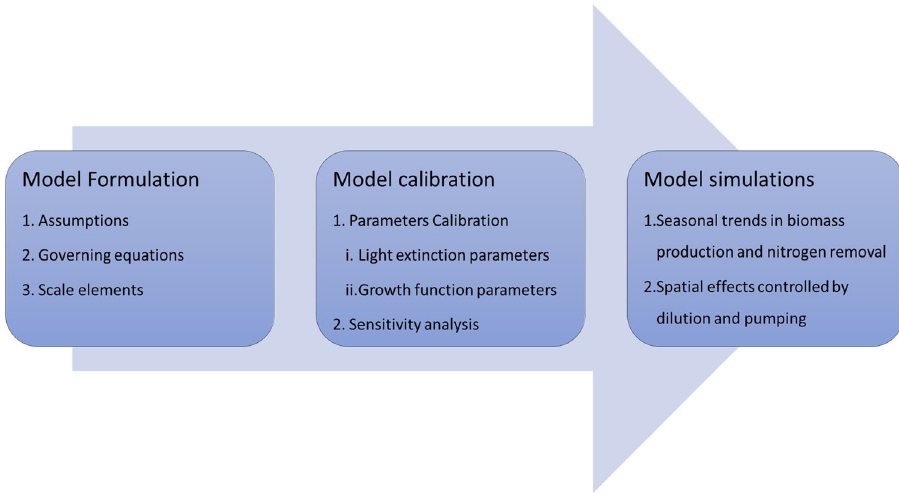
Fig. 7 Flowchart of study methodology. Step 1: model formulation, including assumptions, governing equations and scale elements; step 2: model calibration, including light extimction and growth function parameters, and a sensitivity analysis, and step 3: model simulations, including seasonal trends in biomass production and nitrogen removal and spatial effects controlled by dilution and